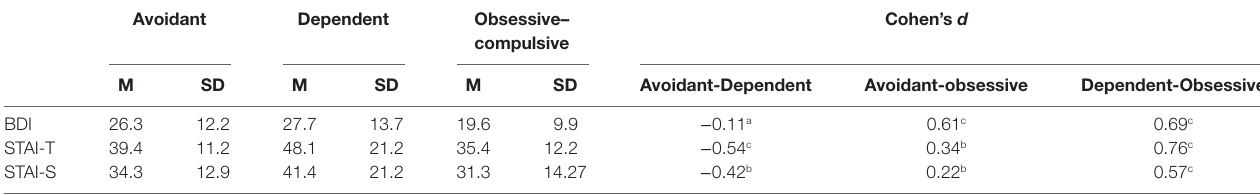
Table 4 | Relationships among depression and anxiety. Without personality clusters cluster c avoidant Dependent Obsessive–comp. disorder a and b